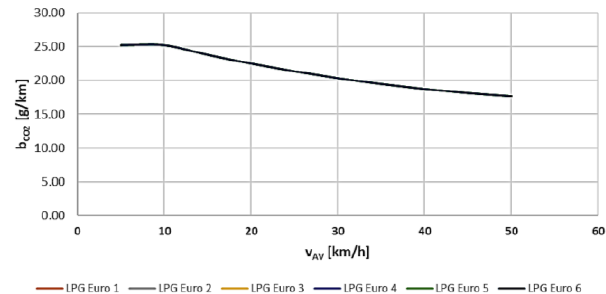
Fig. 8. CO 2 emission from LPG PCs for vehicle depending on average speed